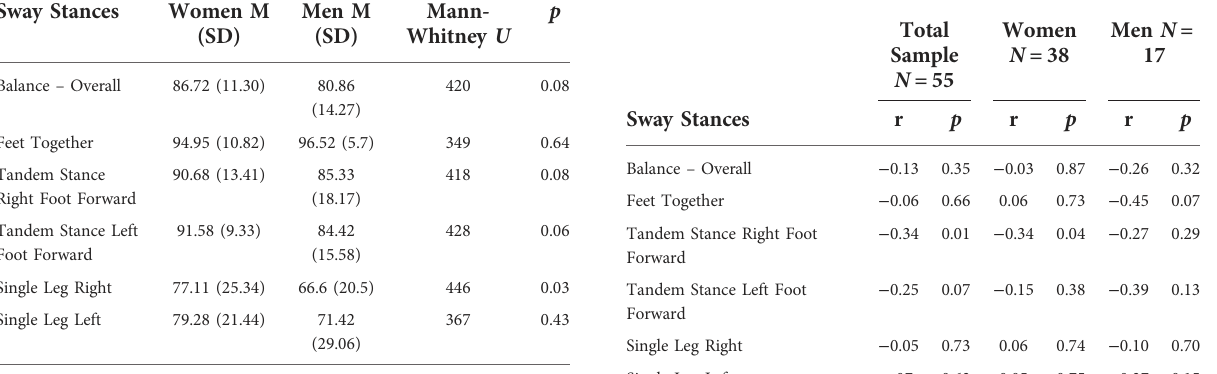
TABLE 6 Sex differences in Sway Balance scores for week 1. TABLE 7 Spearman ’ s Rho correlations between age and Sway Balance scores for week